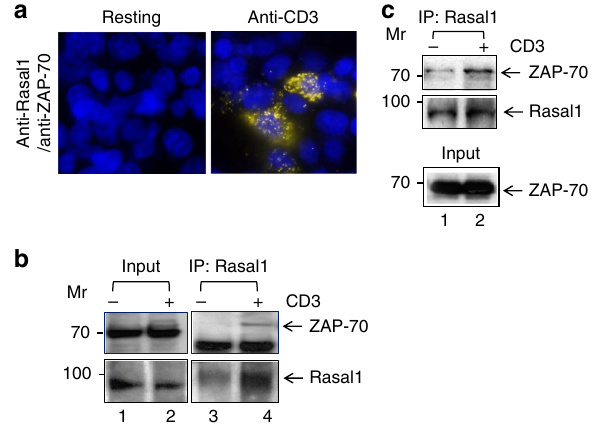
Fig. 2 Rasal1 binds to the immune cell tyrosine kinase ZAP-70. a Proximity ligation assay (PLA) of Rasal1 and ZAP-70 in Jurkat T-cells stained with DAPI, anti-Rasal1, and anti-ZAP-70. Positive PLA signal ( fl uorescent dots) indicates a distance of 30 – 40 nm between Rasal1 and ZAP-70 in anti-CD3-activated T cells, indicating their close proximity ( n = 2). b Anti-Rasal1 co-precipitates ZAP-70 from primary mouse T cells. Lane 1 – 2 loading controls, lanes 3-4: anti-Rasal1 IP: lanes 2 and 4. Cells were stimulated with anti-CD3 ligation for 5 min vs IgG control ligation in lanes 1 and 3. c Anti-Rasal1 co-precipitates ZAP-70 from transfected Jurkat T cells. Lanes 1: nonligated (i.e., IgG); lane 2: anti-CD3 ligated T cells for 5 min. Lower panel shows similar level of ZAP-70 expression in lysates of ( n =